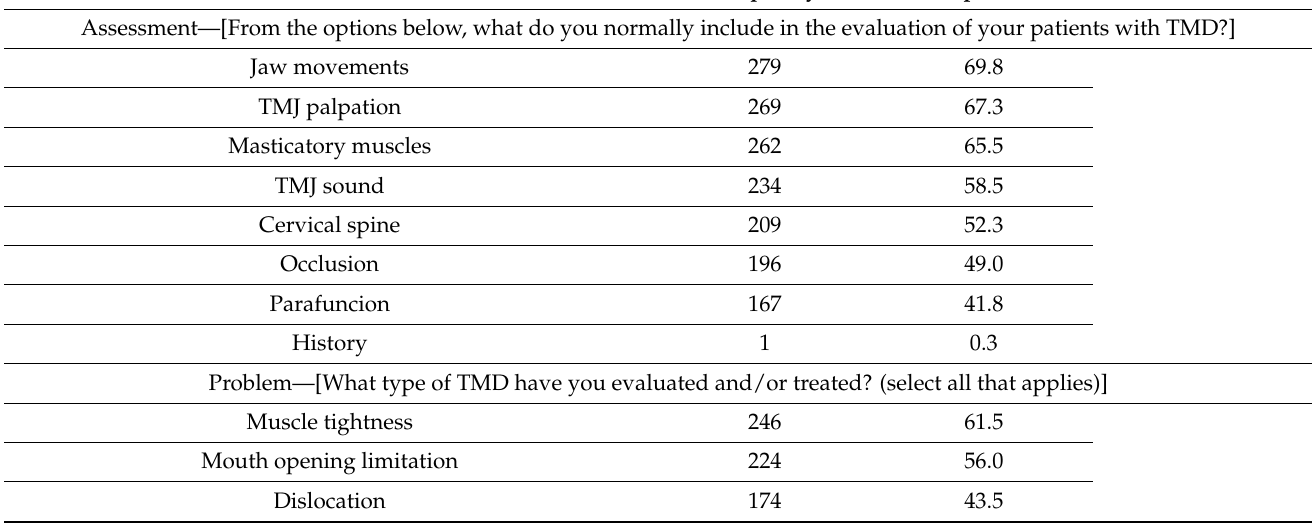
Table 1. Demographic details and